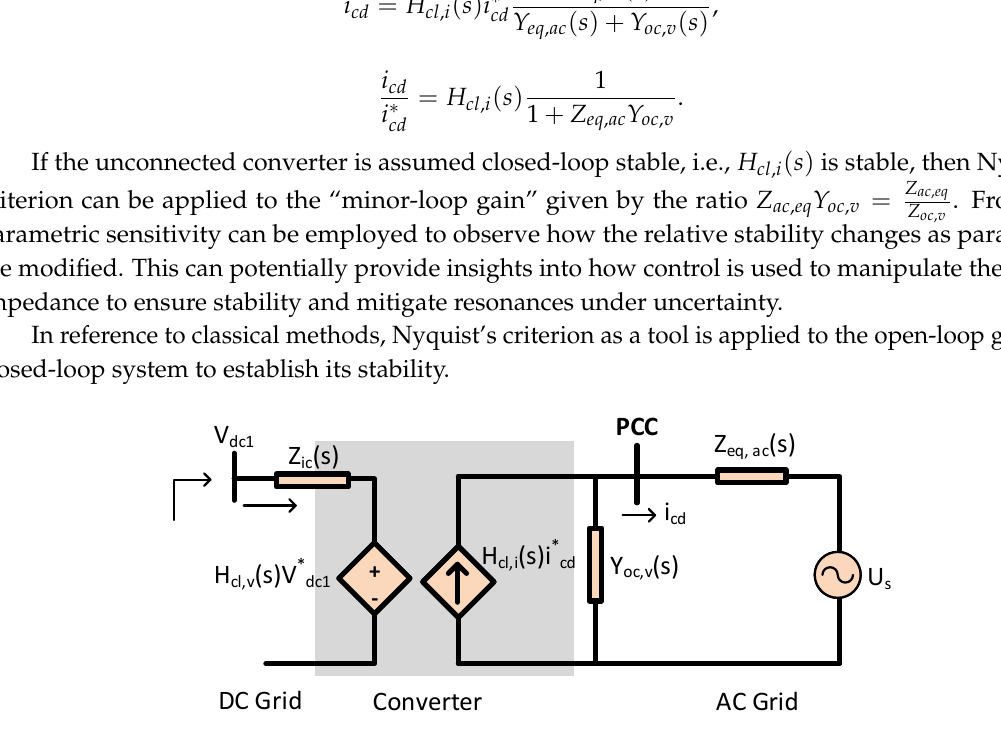
Figure 10. Impedance model of converter and connected grid